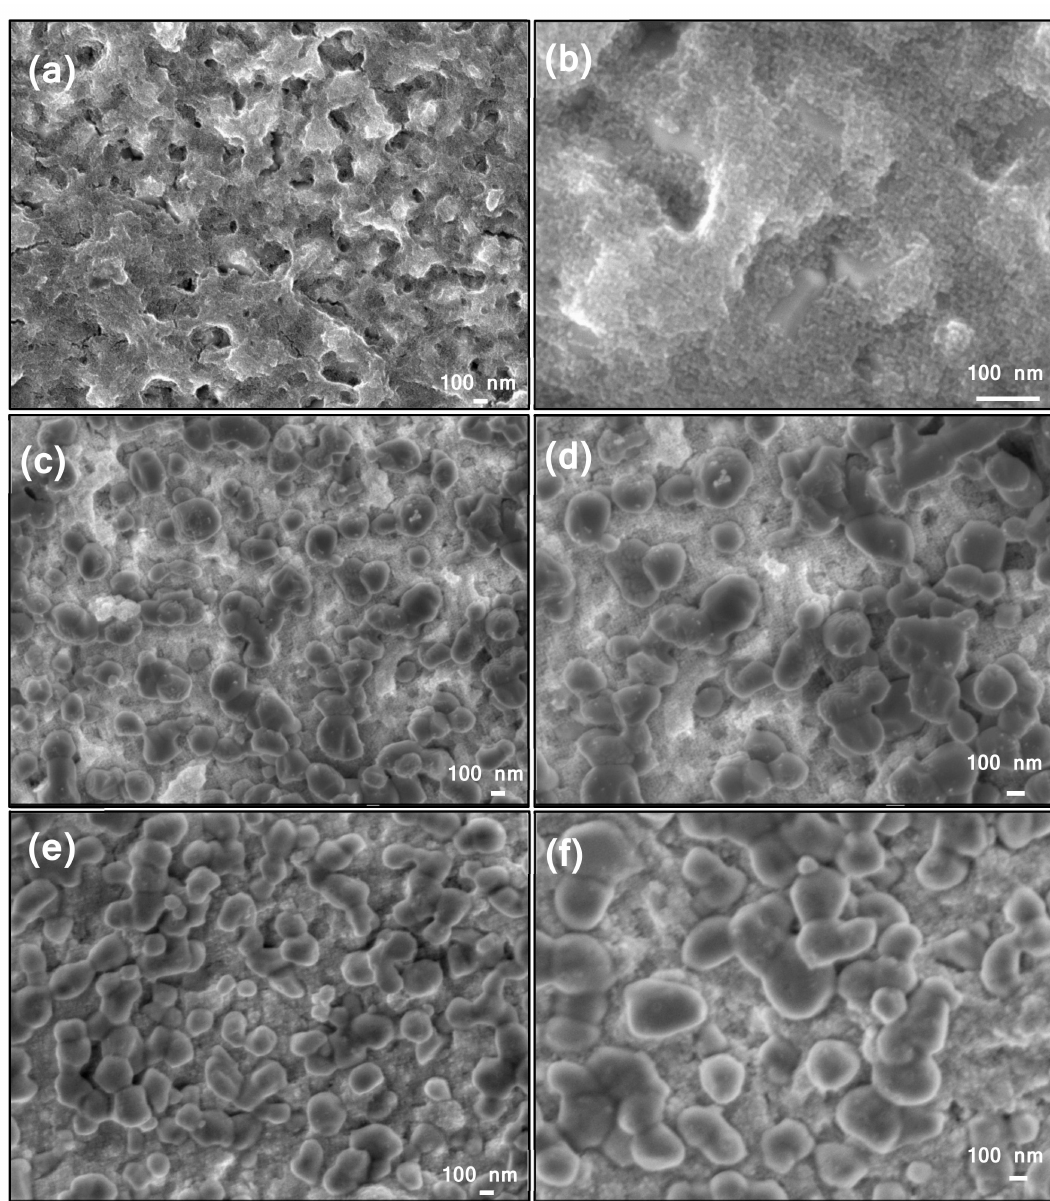
Figure 3. Structural characteristics of photoanodes. Field emission Scanning electron microscope images at ( a ) low-magnification and ( b ) high-magnification of SnO 2 nanoparticles fabricated using